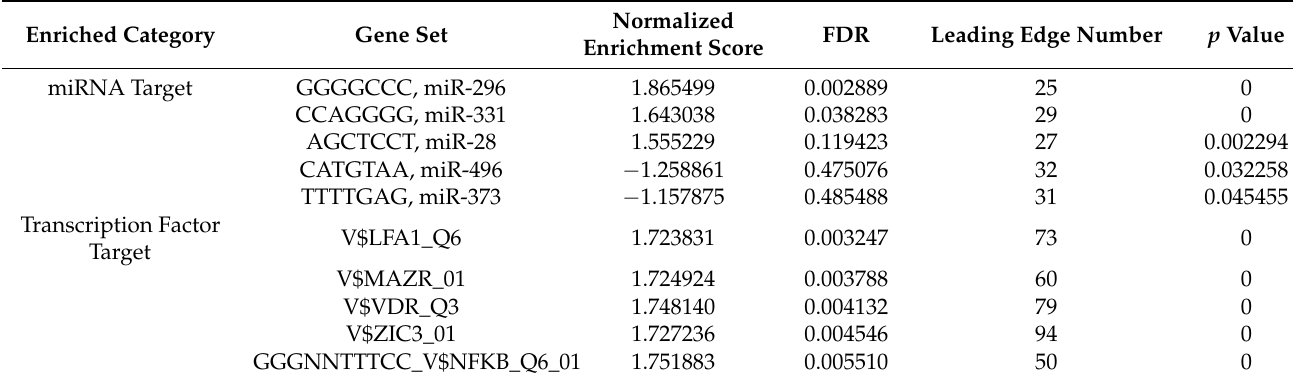
Table 1. The miRNA- and transcription factor-target networks highly associated with DLK2 in ccRCC